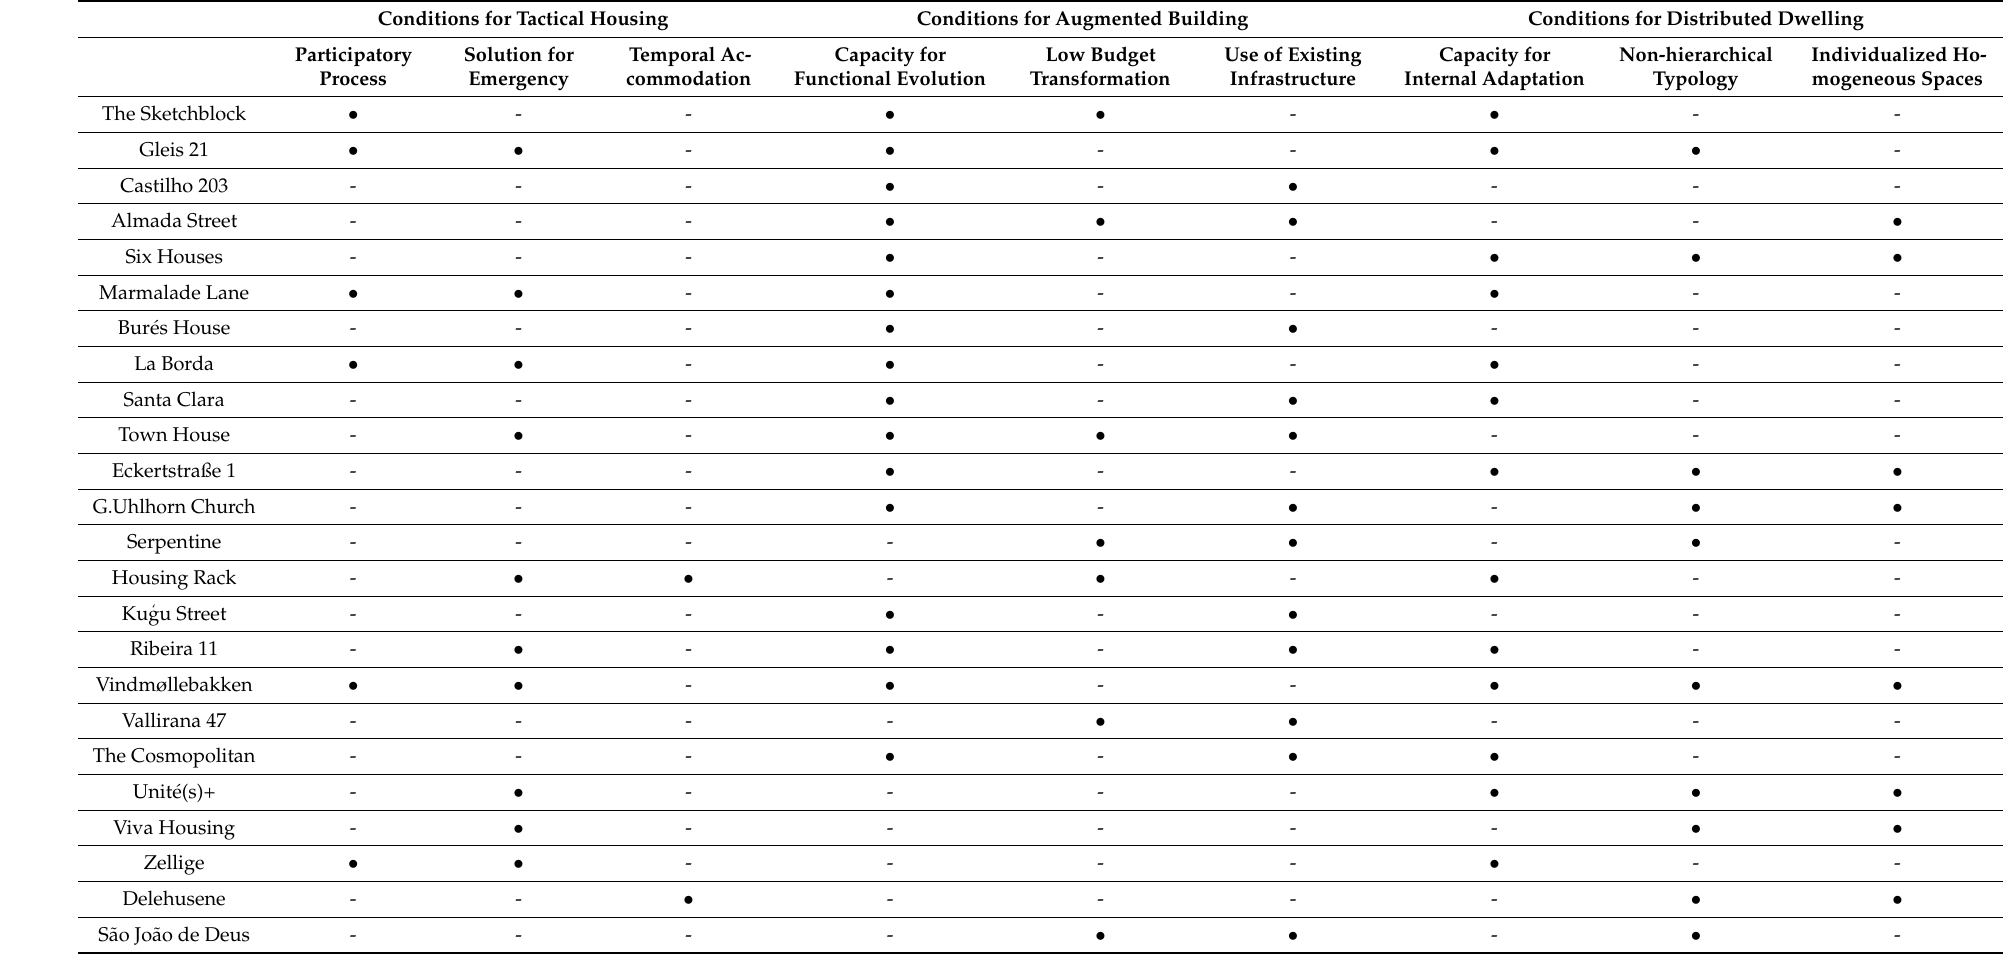
Table 3. Analysis applied to case